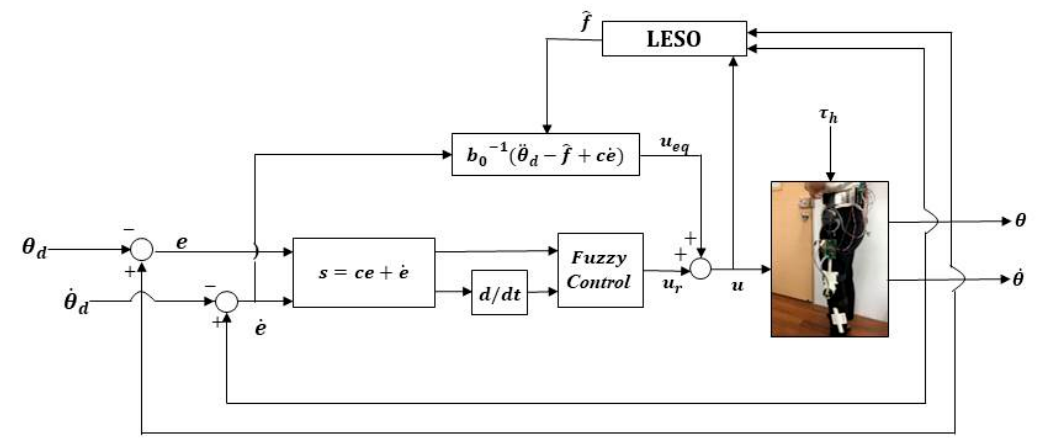
Figure 4. Control structure of LESO-based FSMC.